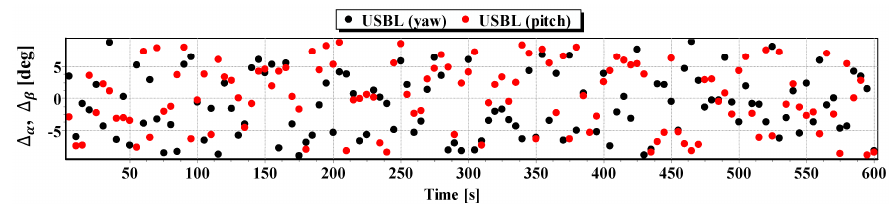
Figure 11. Graph of simulated measurement error ∆ α , ∆ β .